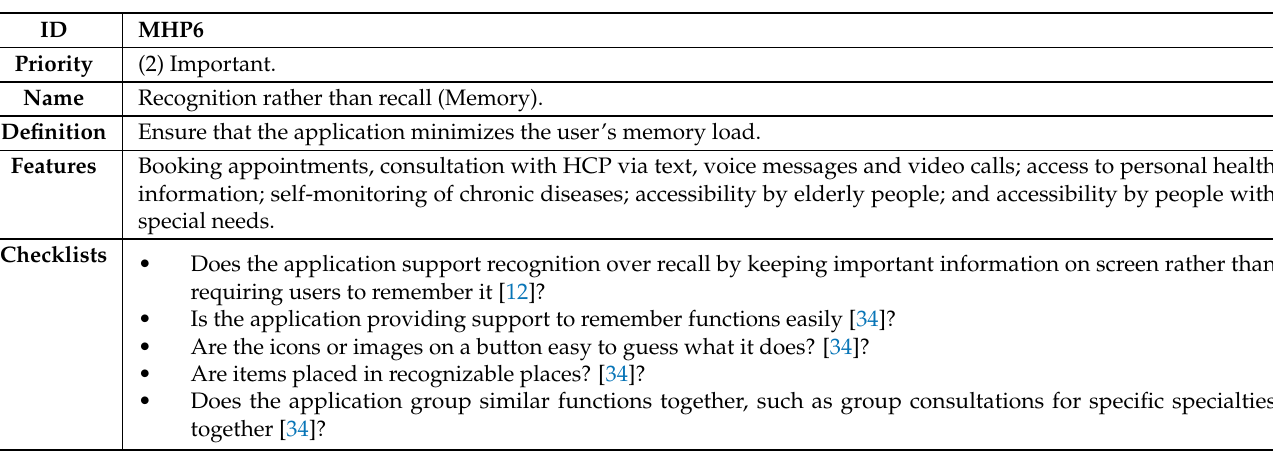
Table A6. Descriptive details of the sixth guideline.